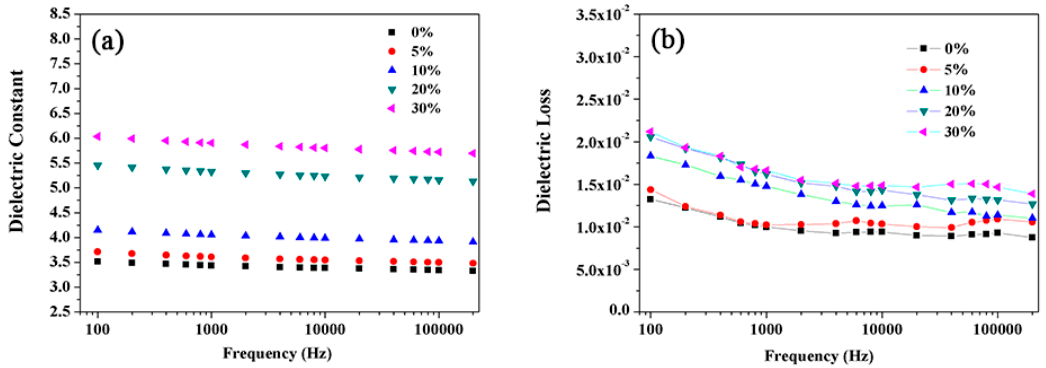
Figure 7. ( a ) SEM image of BT@ZnPc-2/PEN film; ( b ) SEM image of BT@ZnPc-2/PEN film after isothermal annealing at 280 °C for 5 hours.